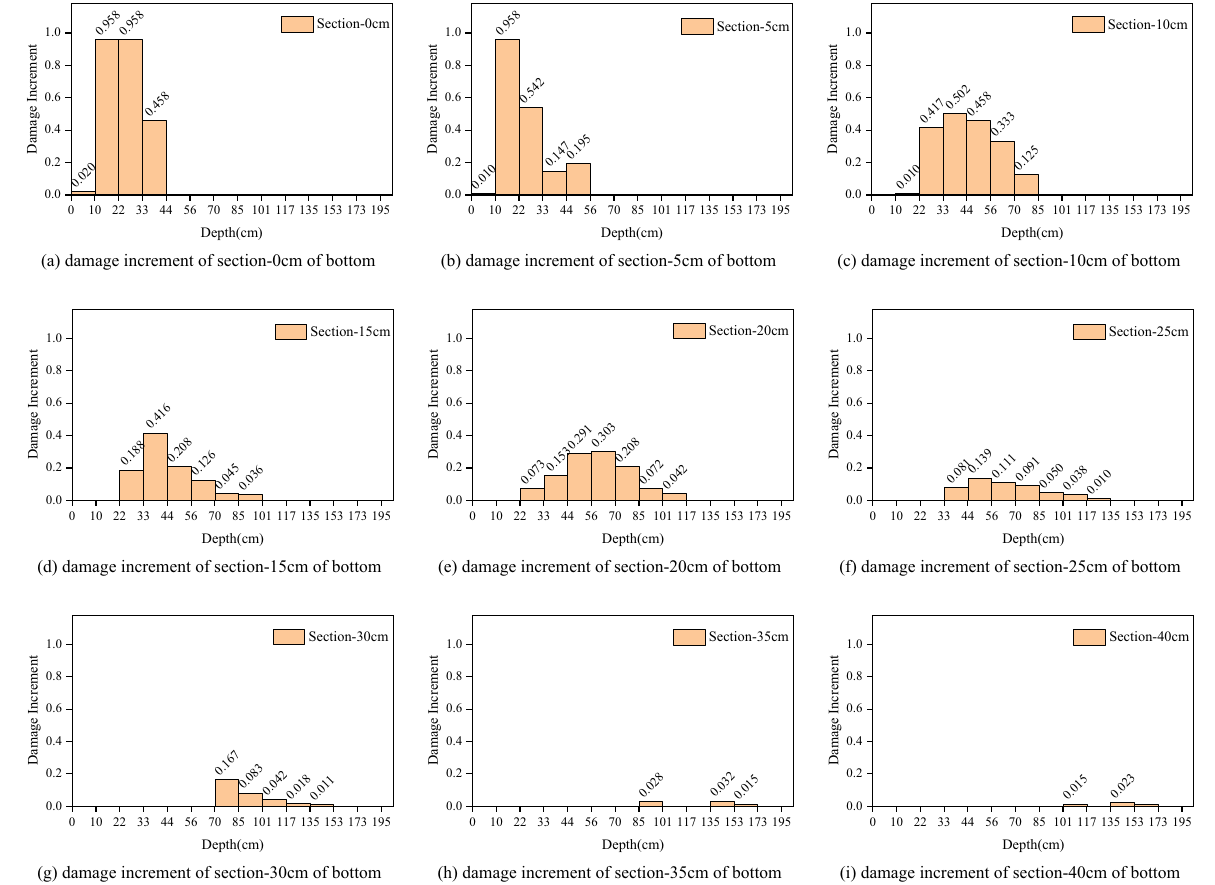
Figure 18. Damage increment distribution along the depth of surrounding rock in different sections of the